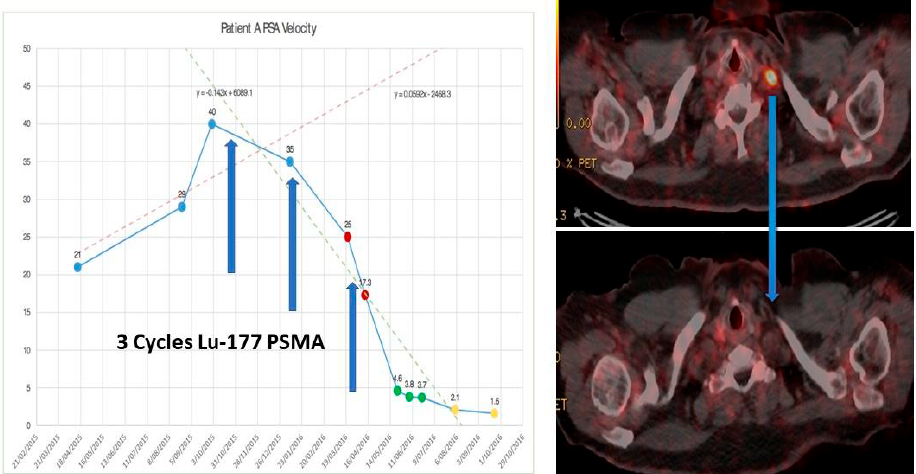
Figure 6. Before ( top ) and after ( bottom ) 3 cycles of 177 Lu-PSMA therapy for progressive metastatic castrate resistant prostate cancer. [X axis—PSA in microgram/; Y axis—time in months].